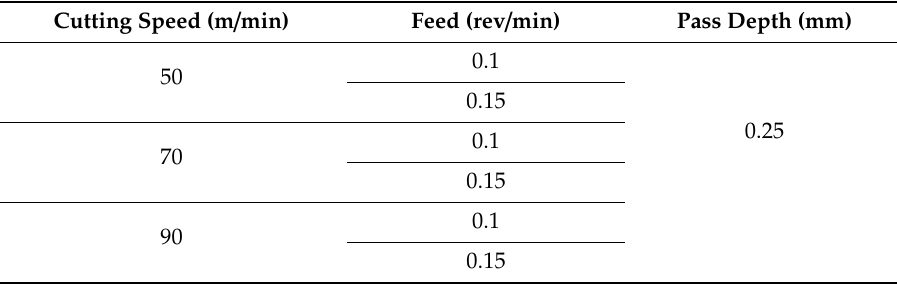
Table 2. Cutting parameters for the turning